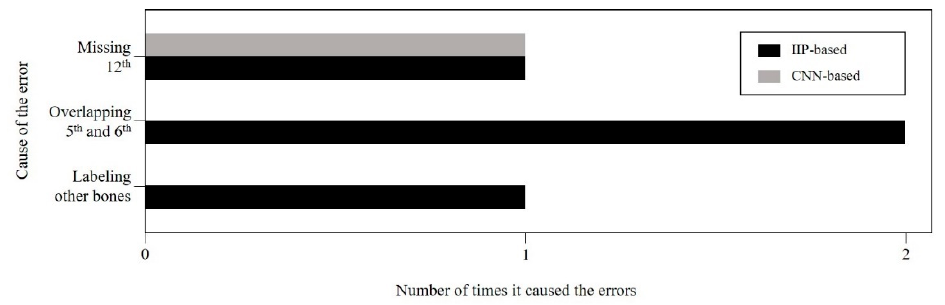
Figure 7. Cause of errors in intensity-based image processing (IIP)-based and convolutional neural network (CNN)-based methods.